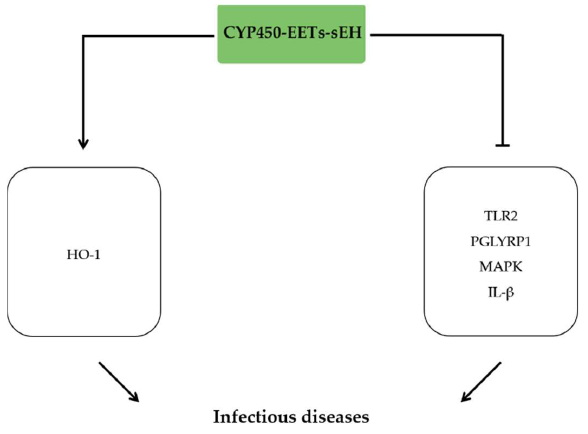
Figure 5. The anti-inflammatory effects of EETs in systemic infectious disease. EETs ameliorate in-